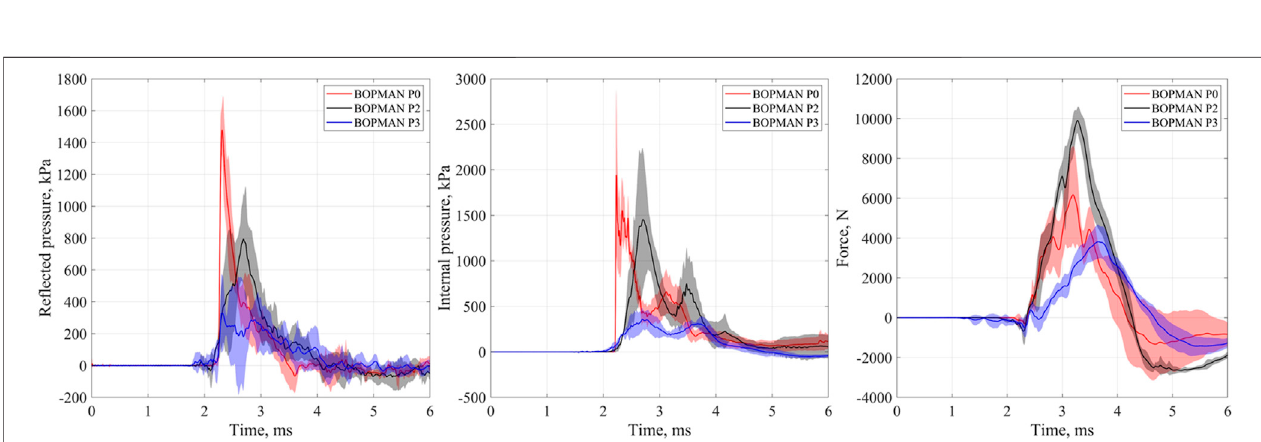
FIGURE 5 | Maximal right thoracic wall costal acceleration (A) and velocity (B) for the three tested levels of thoracic protection: P0, P2, and P3. *: p < 0.05, **: p < 0.01, and ***: p < 0.001 (Mann-Whitney test); (C) and (D) : relationship between swine thoracic wall motion level (chest acceleration and velocity, respectively) and lung injury outcomes. Linear fi t equations are given on the graphs.